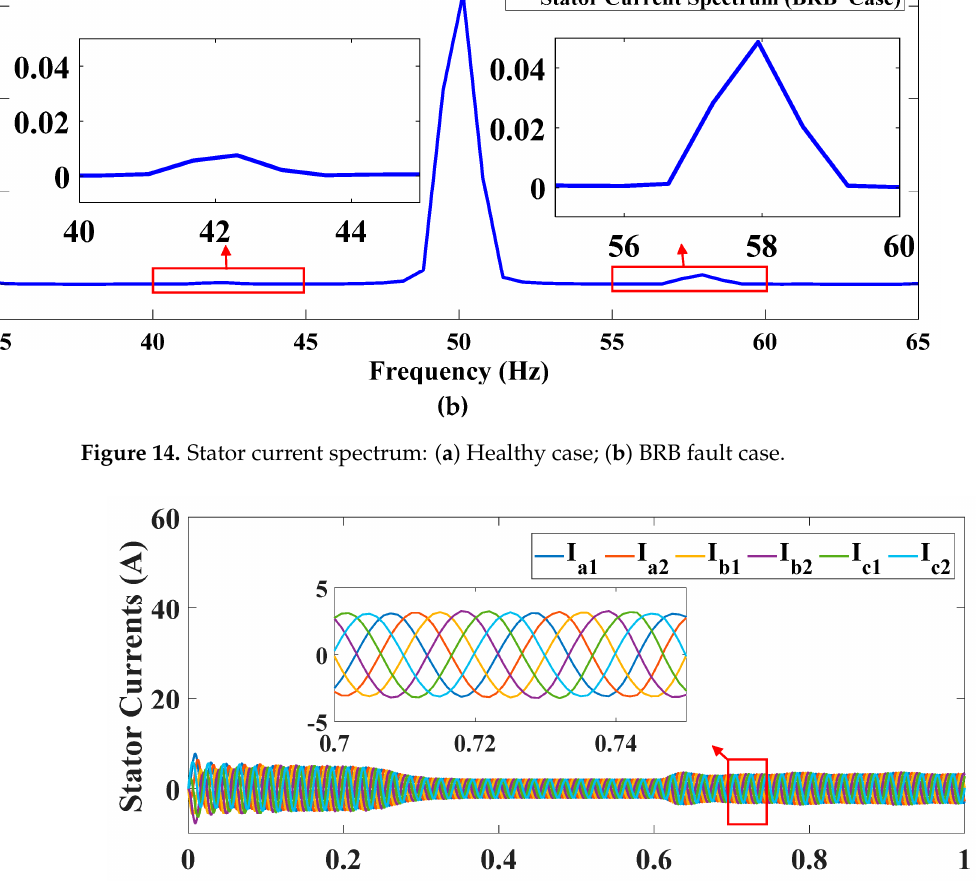
Figure 14. Stator current spectrum: ( a ) Healthy case; ( b ) BRB fault case.